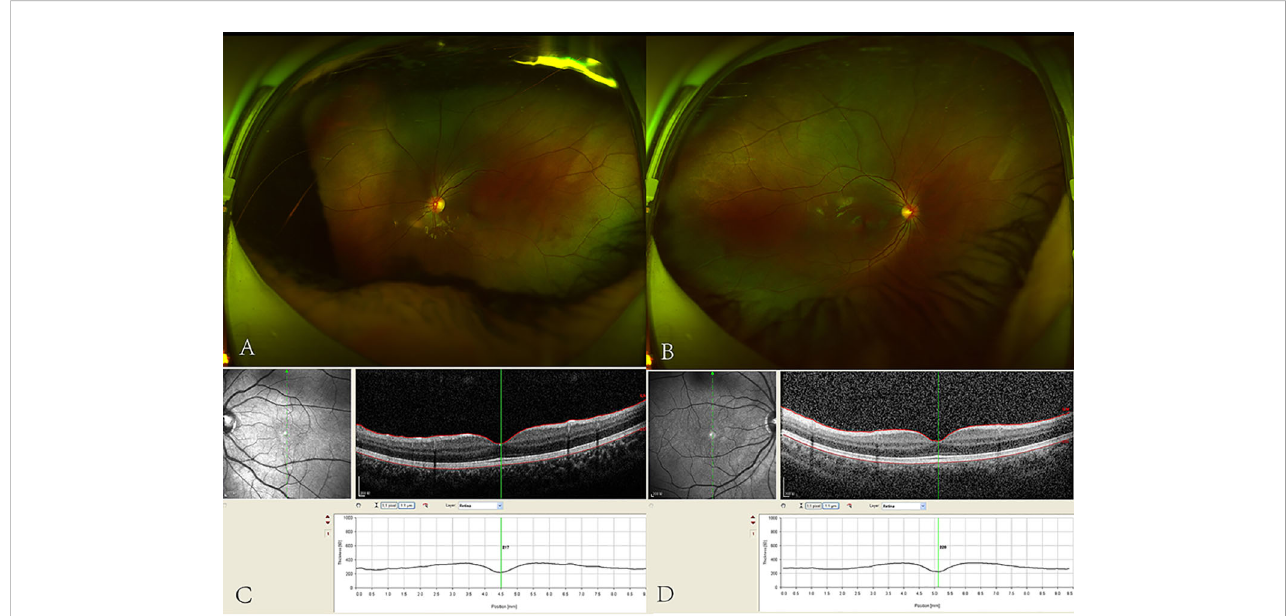
FIGURE 1 Fundus photography and OCT of the four-year-old Chinese girl. (A) Fundus photography of left eye. (B) Fundus photography of right eye. (C) OCT of the macular fovea and thickness of retinal layer on left eye. (D) OCT of the macular fovea and thickness of retinal layer on right